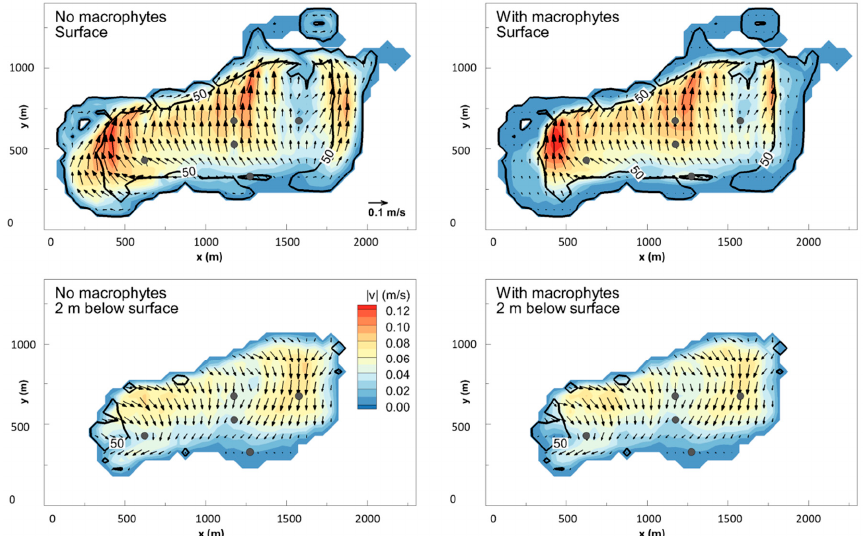
Figure 5. Modelled circulation patterns with and without the littoral macrophytes at the surface and at 2 m below the surface. The solid contour lines delineate the area where velocity magnitude changed at least with 50% by the inclusion of macrophytes. The circulation field represents the same 5-hour averages as Figure 4.